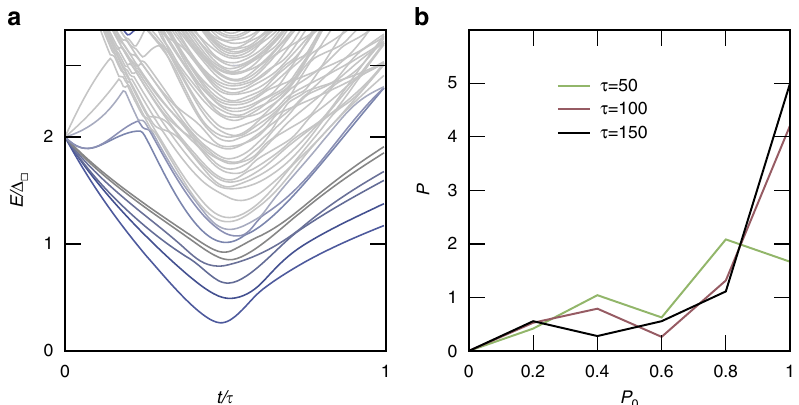
Figure 4 | Spectrum and success probabilities. ( a ) Illustration of the time-dependent spectrum for the minimal instance shown in Fig. 1. ( b ) Histogram of the success probability, that is, the probability P 0 to populate the ground state at final time t for different